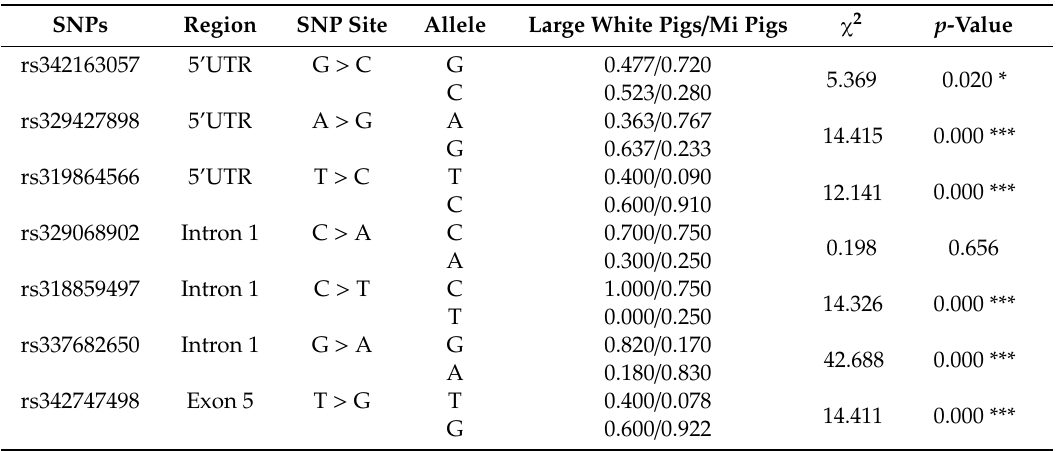
Figure 2. The linkage disequilibrium (LD) analysis of 7 SNPs in the porcine HSD17B14 gene. ( a ) The position of seven SNPs in the porcine HSD17B14 gene. ( b ) LD analysis of the seven potential SNPs in Large White gilts. ( c ) LD analysis of the seven potential SNPs in Mi gilts. Table 1. The allele frequencies of single nucleotide polymorphisms (SNPs) in the porcine HSD17B14 gene for Large White and Mi